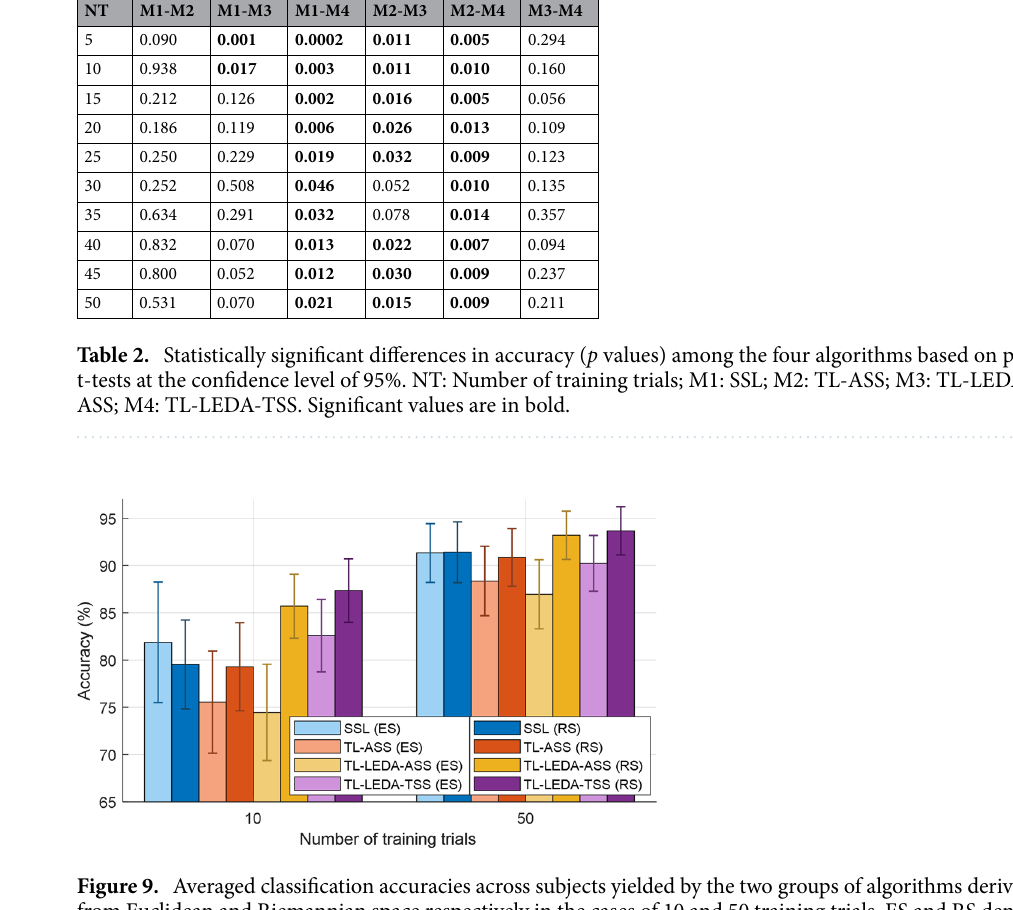
(5) Riemannian space vs Euclidean space: Fig. 9 shows the comparison of averaged classification accuracies across subjects yielded by the two groups of algorithms developed in Euclidean and Riemannian space respectively in the cases of 10 and 50 training trials. It is clearly observed from the figure that for the two numbers of training trials, the subject-specific learning algorithm from Euclidean space performs bet- ter than or equal to that from Riemannian space, whereas the three transfer learning algorithms from Riemannian space are superior to those from Euclidean space. Using the subject-specific algorithm from